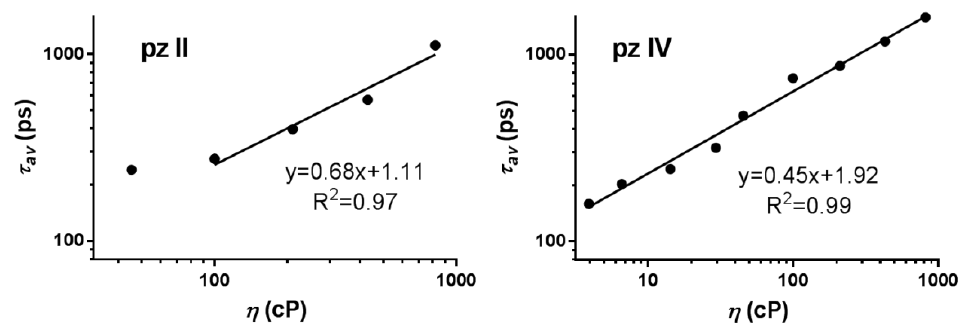
Figure 5. Dependence of the fluorescence lifetime of pz II and pz IV on the viscosity measured in ethanol–glycerol solutions. The data followed the Förster–Hoffmann equation with coefficients of viscosity sensitivity of 0.68 and 0.45, respectively.